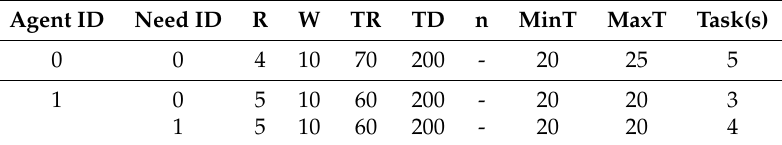
Table 5. Agents’ needs for Scenario